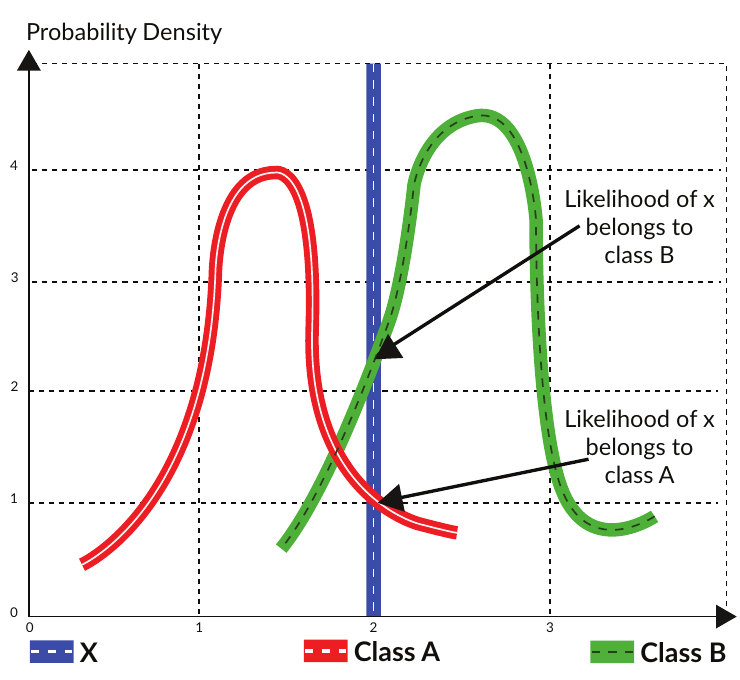
Figure 8. Principle of maximum likelihood